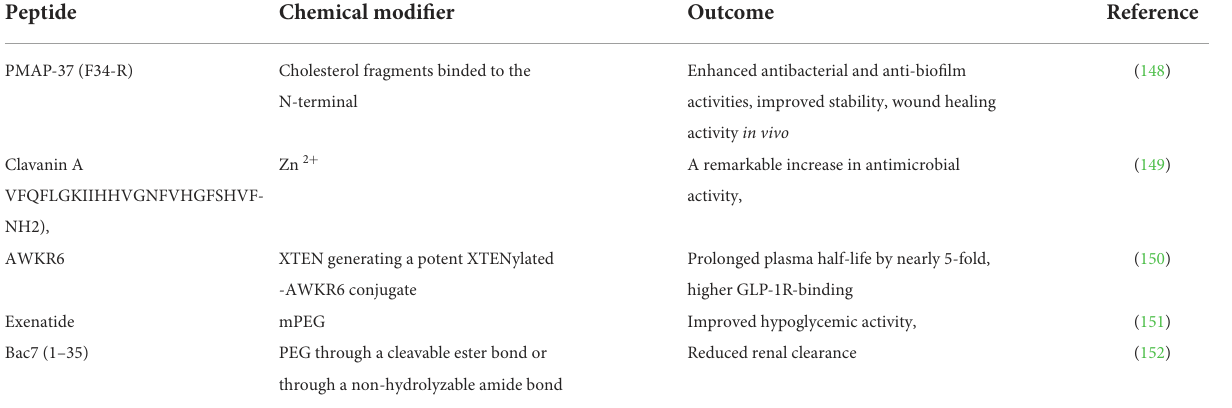
TABLE 4 Chemical modification of food-derived bioactive peptide (s).